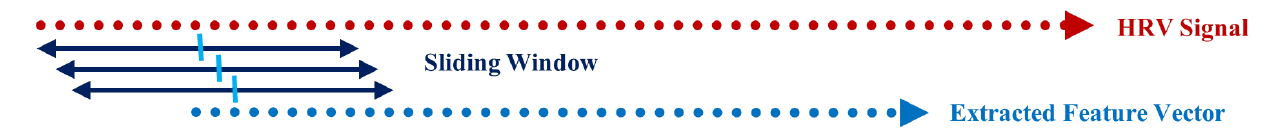
Figure 3. Schematic representation of the extraction of a feature using one of the sliding windows. In the end, we obtained a total of 558 feature vectors, corresponding to the 31 features times 18 window sizes for each experiment run.